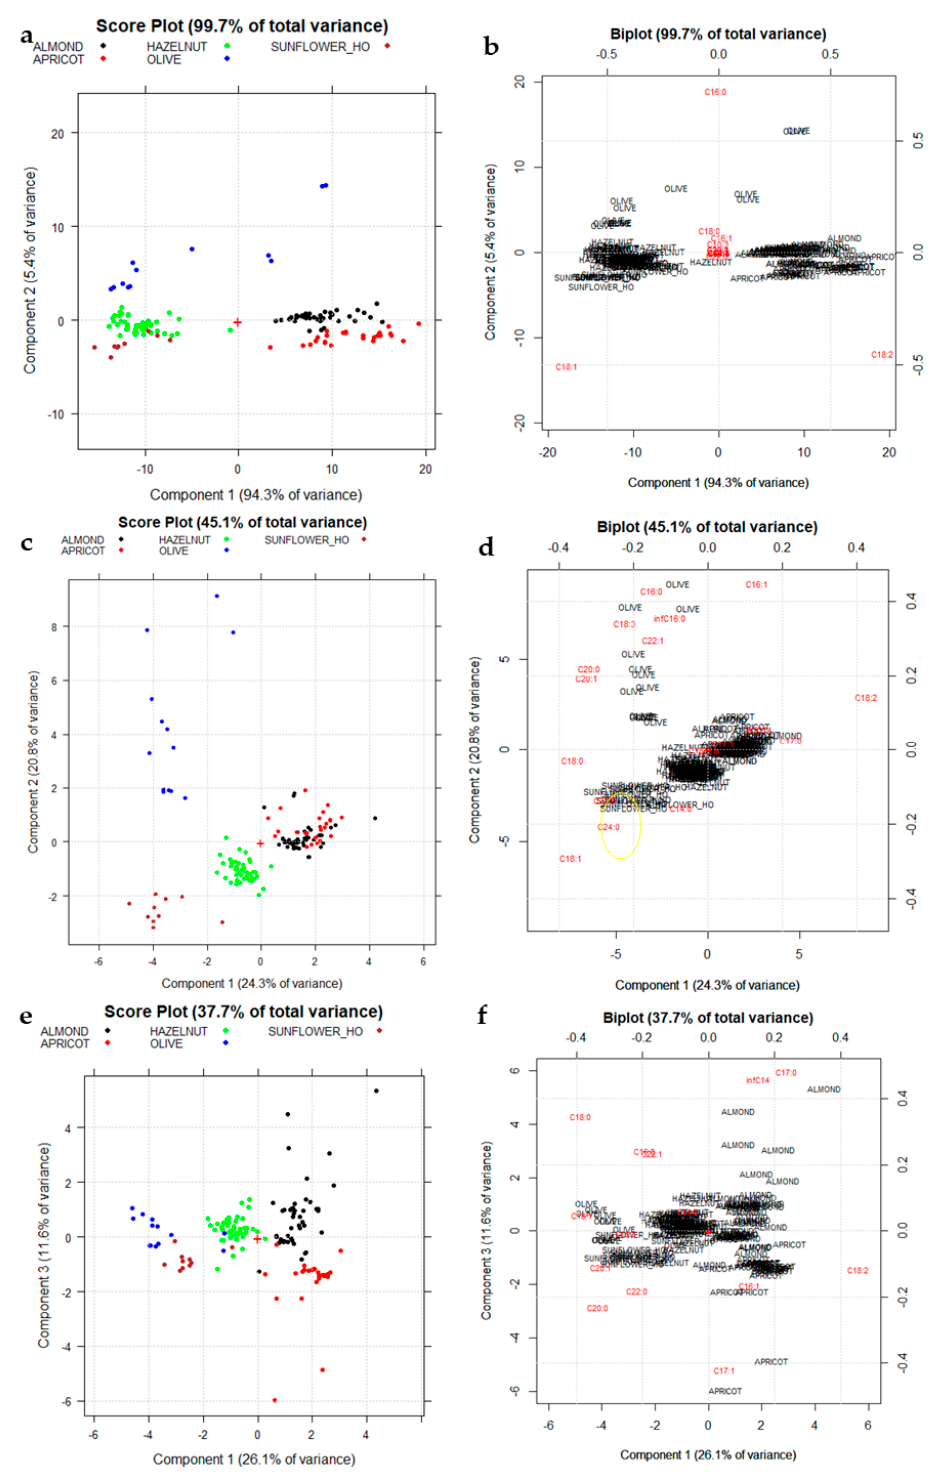
Figure 4. ( a ) Score plot on the first two principal components (PC1 vs. PC2) data matrix C 140,18 after column centering. Each vegetable species is reported with a different color (Almond: black, Apricot: red, Hazelnut: green, Olive: blue, Sunflower_HO: brown); ( b ) Biplot on PC1–PC2 after column-centering: loadings are reported in red ink; ( c ) Score plot on the first two principal components (PC1 vs. PC2) data matrix C 140,18 after autoscaling; ( d ) Biplot on PC1–PC2 after autoscaling: loadings are reported in red ink; ( e ) Score plot on PC1–PC3 data matrix C 140,18 after autoscaling; ( f ) Biplot on PC1–PC3 after autoscaling: loadings are reported in red ink. + sign in the plots correspond to the origin (point